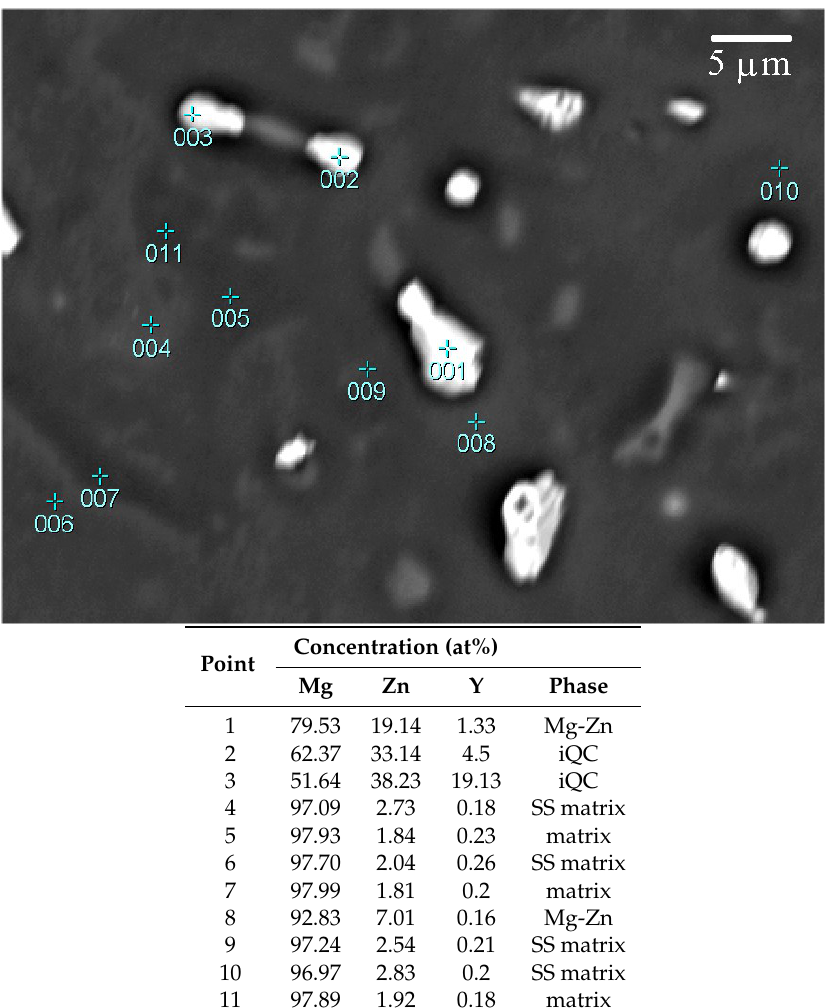
Figure 8. A backscattered SEM image from a sample near the wall of the water-cooled casting. The compositions at points indicated in the image are given in the accompanying